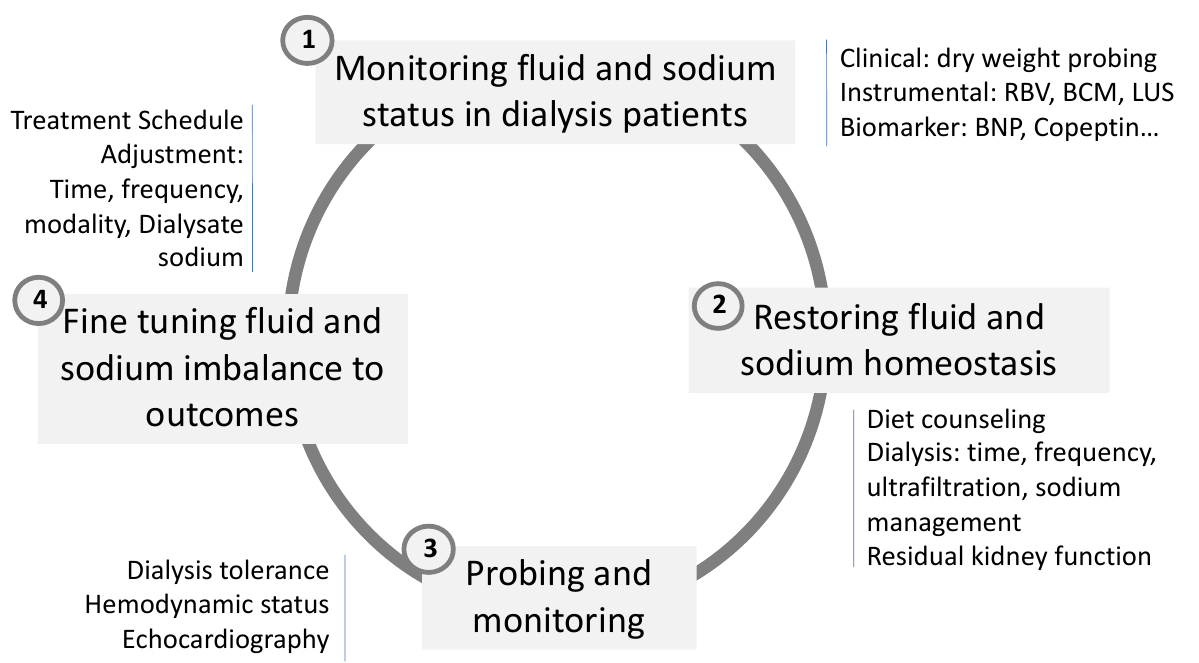
Figure 4. Four clinical steps involved in sodium, water, and fluid volume management in HD pa- tient.